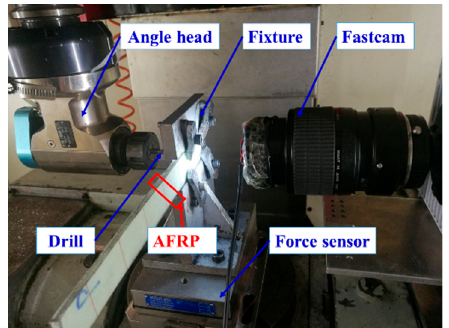
Figure 5. Experiment layout.